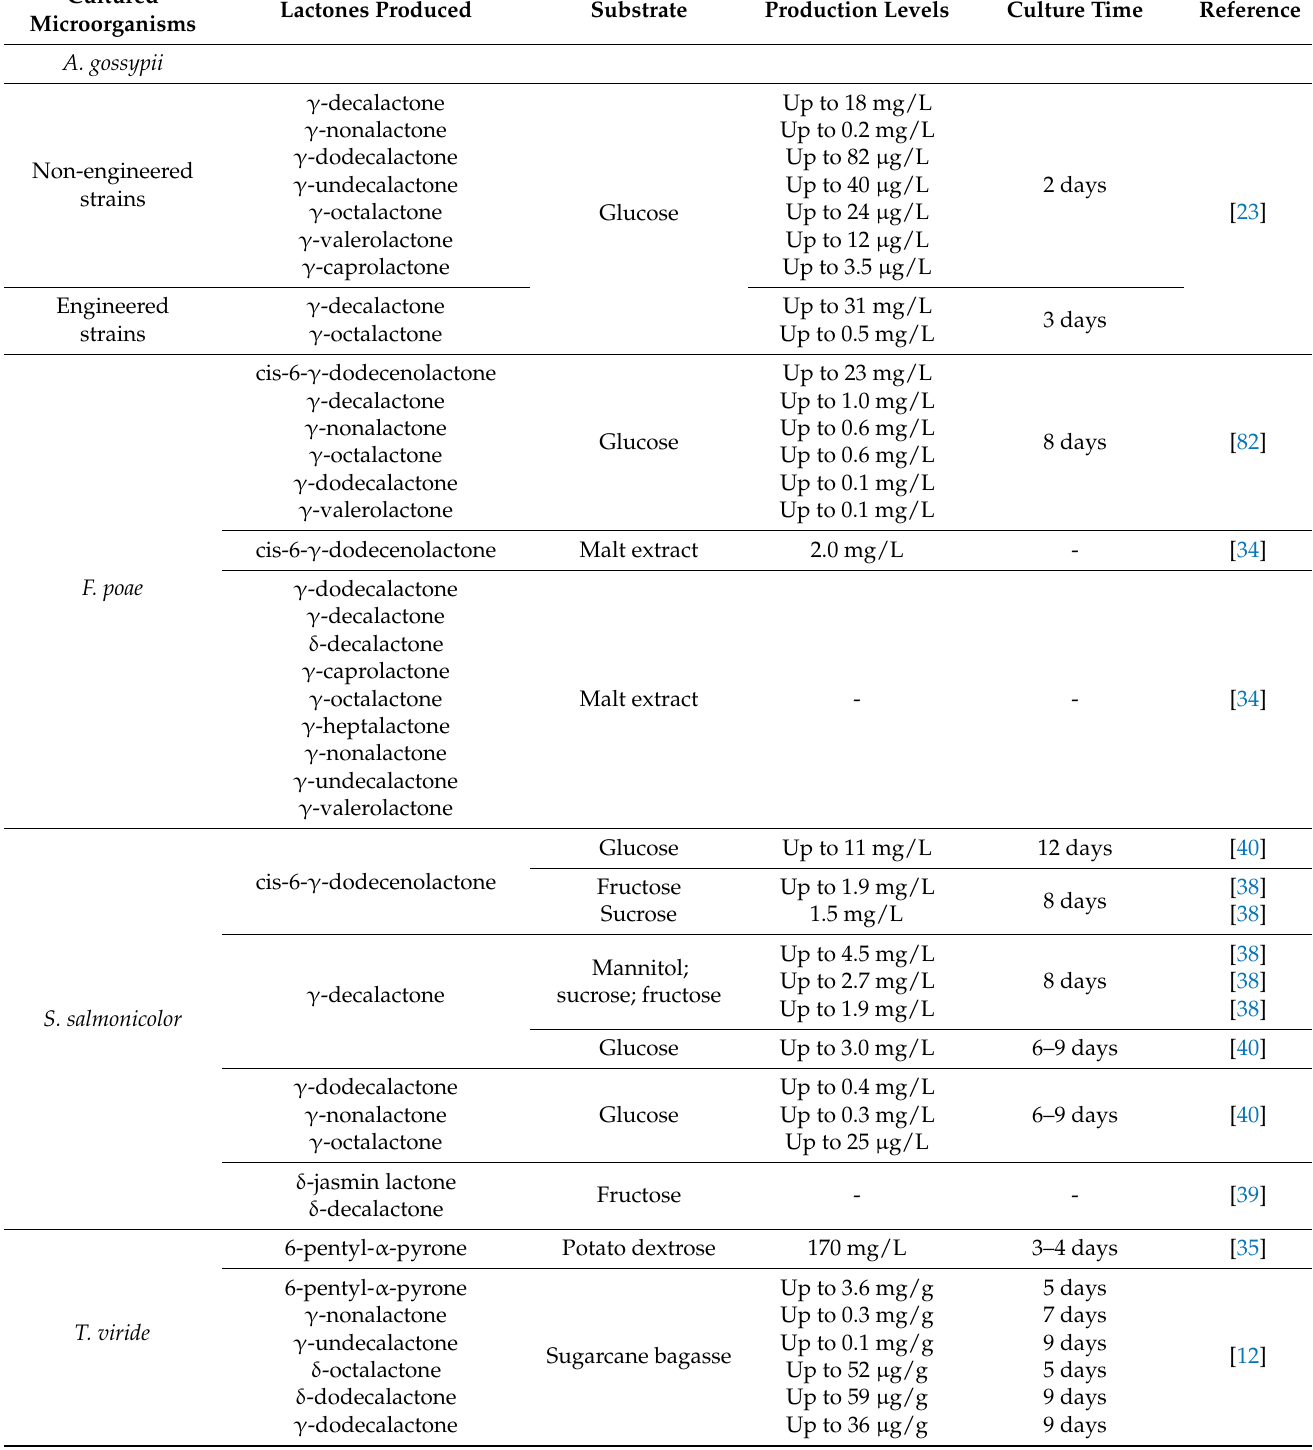
Table 2. Reported production levels of lactones obtained by de novo biosynthesis from different microorganisms and substrates. The production levels for submerged cultures are indicated per volume of culture, and for solid-state cultures per mass of cell dry